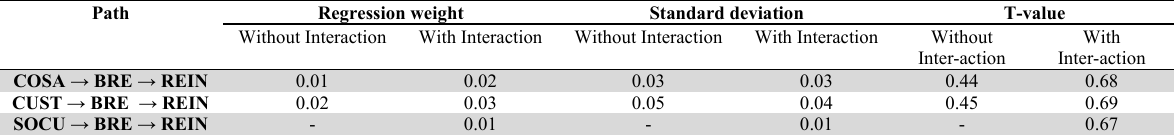
Comparison of regression weight, standard deviation, and t-value between models without interaction and models with inter- actions in the indirect